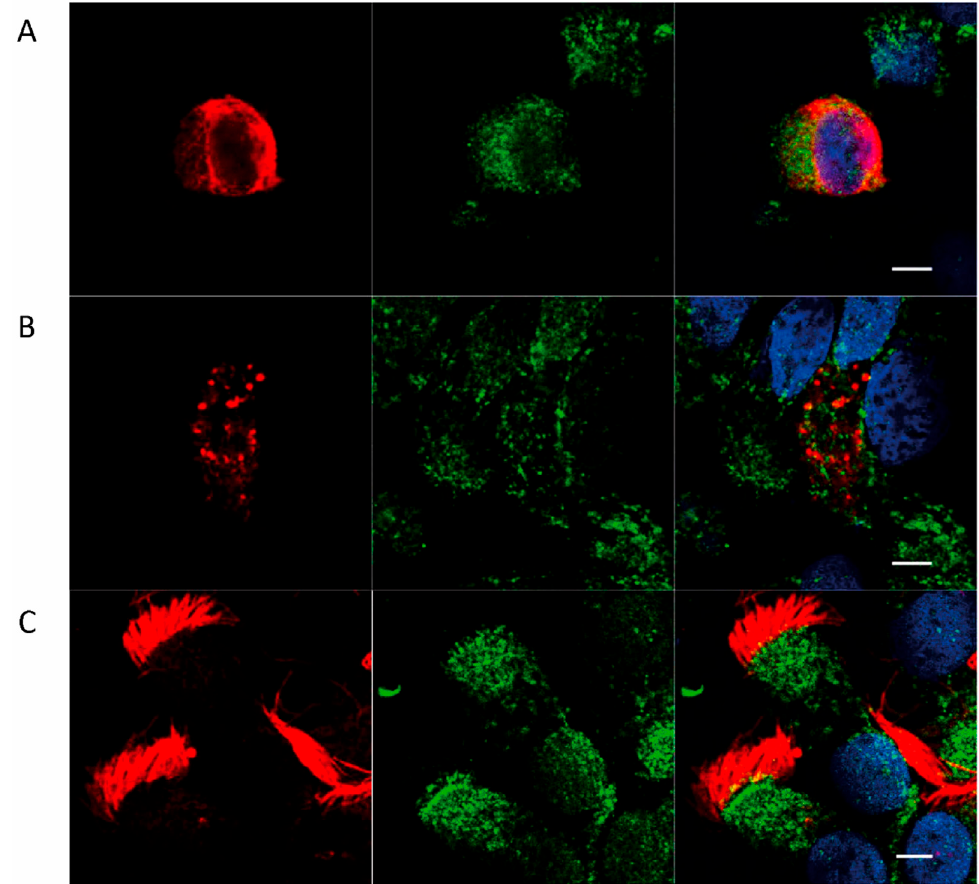
Figure 4. FcRn localization in air–liquid interface culture of human nasal epithelial cells on day 21. Cells were co-immunolabeled for FcRn (green) and ( A ) a basal cell marker, cytokeratin-14 (red), or ( B ) a goblet cell marker, mucin-5AC (red), or ( C ) a ciliated cell marker, acetylated α -tubulin (red); and imaged by confocal microscopy. White scale bars represent 5 μ m.